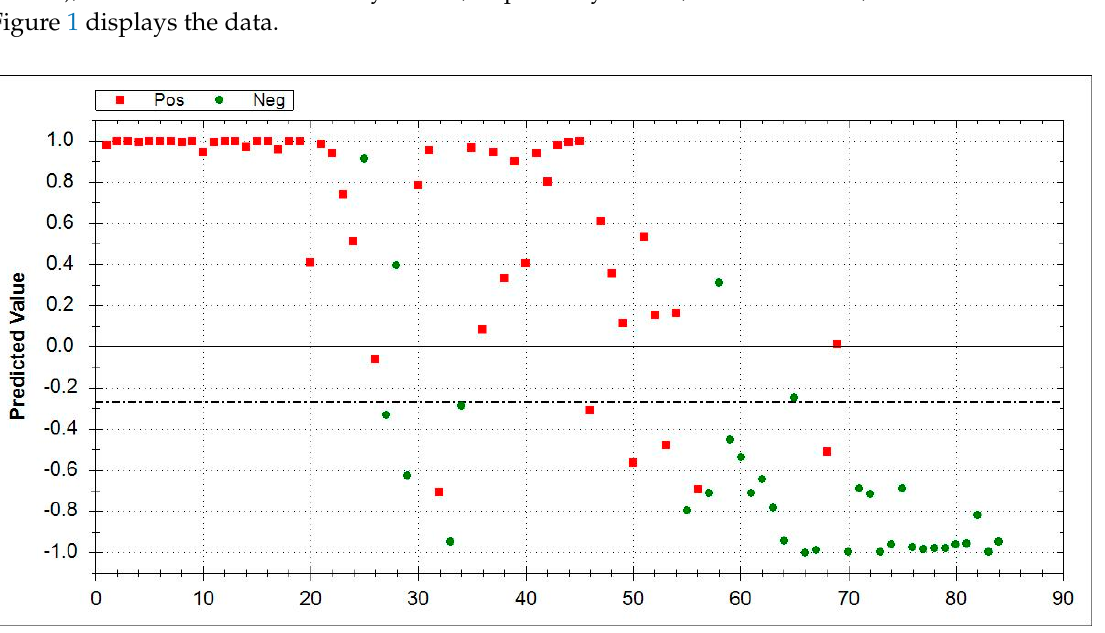
Figure 2. Direct comparison between CTD-ILD ( n = 25, red squares) and HC ( n = 33, green dots) by Aeonose ® . CTD-ILD area 0-1: Red squares indicate correctly recognized CTD-ILD patients while green dots denote false positive patients. HC area 0- -1: Green dots represent correctly-identified healthy controls, while red squares